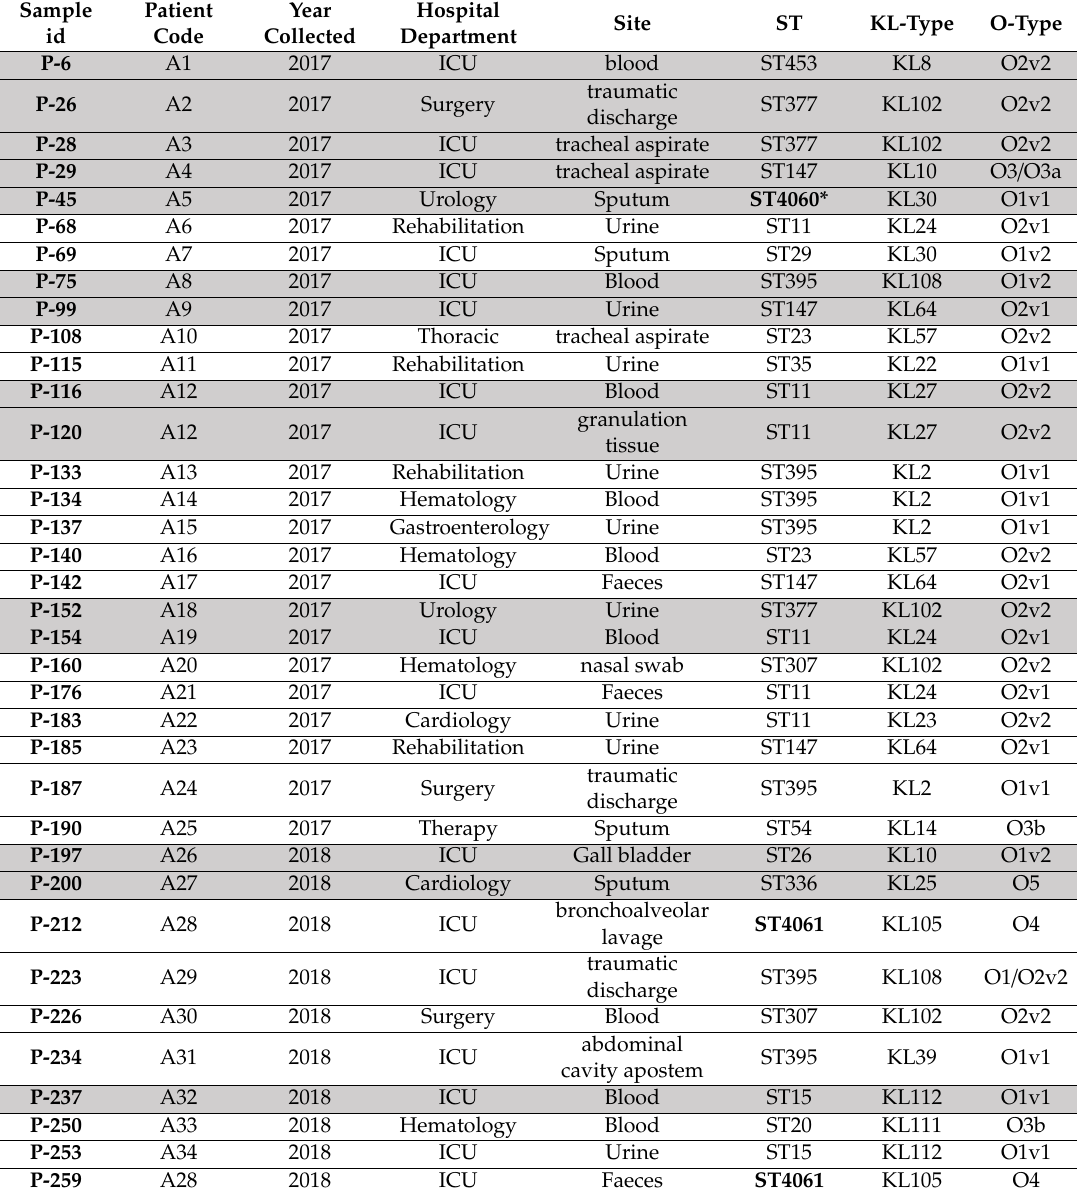
Table 1. Description and molecular typing (multilocus sequence typing (MLST) (ST), capsule synthesis (KL)-type and lipopolysaccharide serotype (O-type)) of the isolates used in the study.